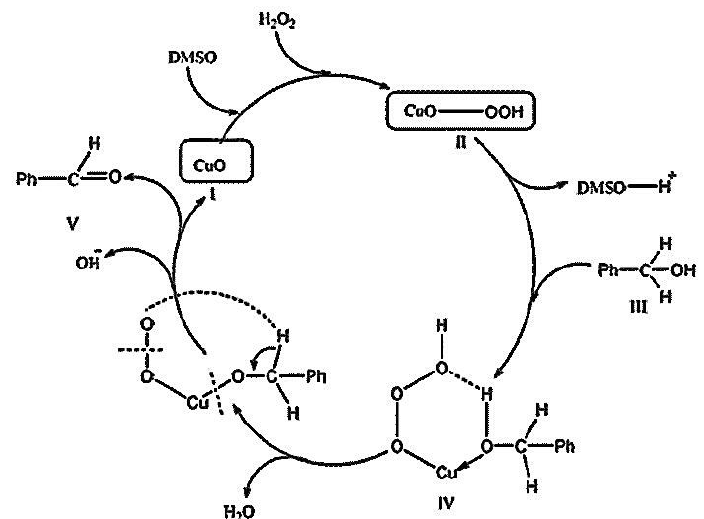
Scheme 2. Proposed mechanism for the catalytic oxidation of benzyl alcohol by